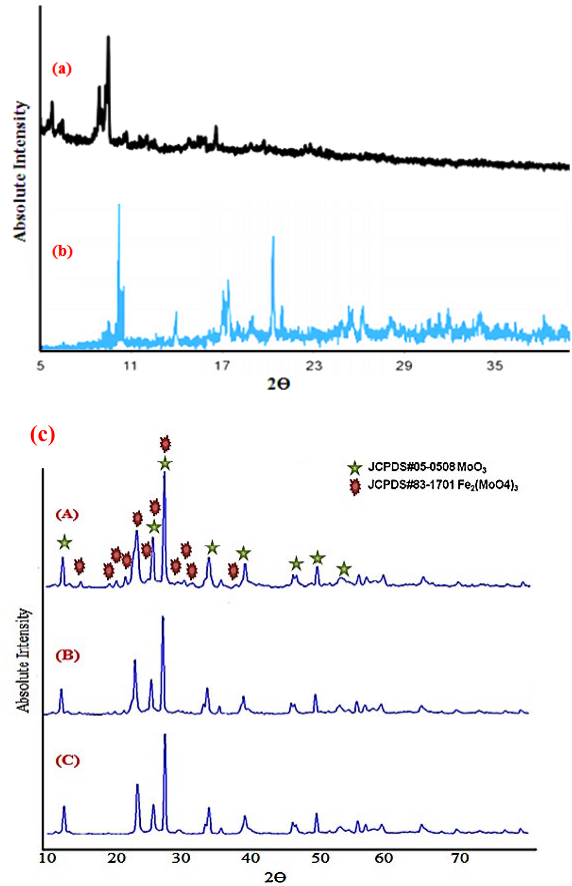
Fig. 3: XRD patterns of (a) MIL-100(Fe), (b) MOF-235 and (c) Fe-MoI (A), Fe-MoII (B) and Fe-MoIII (C). Table 1. BET surface area, Mo/Fe ratio measured from ICP-MS and total pore volume of all